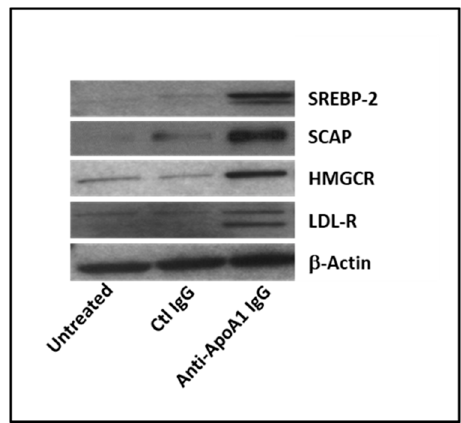
Figure 3. Anti-apoA-1 IgGs interfere with key regulators of cholesterol metabolism in macrophages. Anti-ApoA-1 IgGs induced the expression of the key regulators of the cholesterol pathway after 24 h as evidenced by Western blot. One of four representative Western blot is shown ( n = 4).